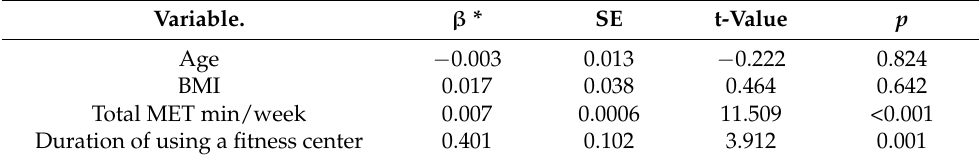
Table 4. Multiple linear regression model of the independent predictors of the total MDSS score. Variable.